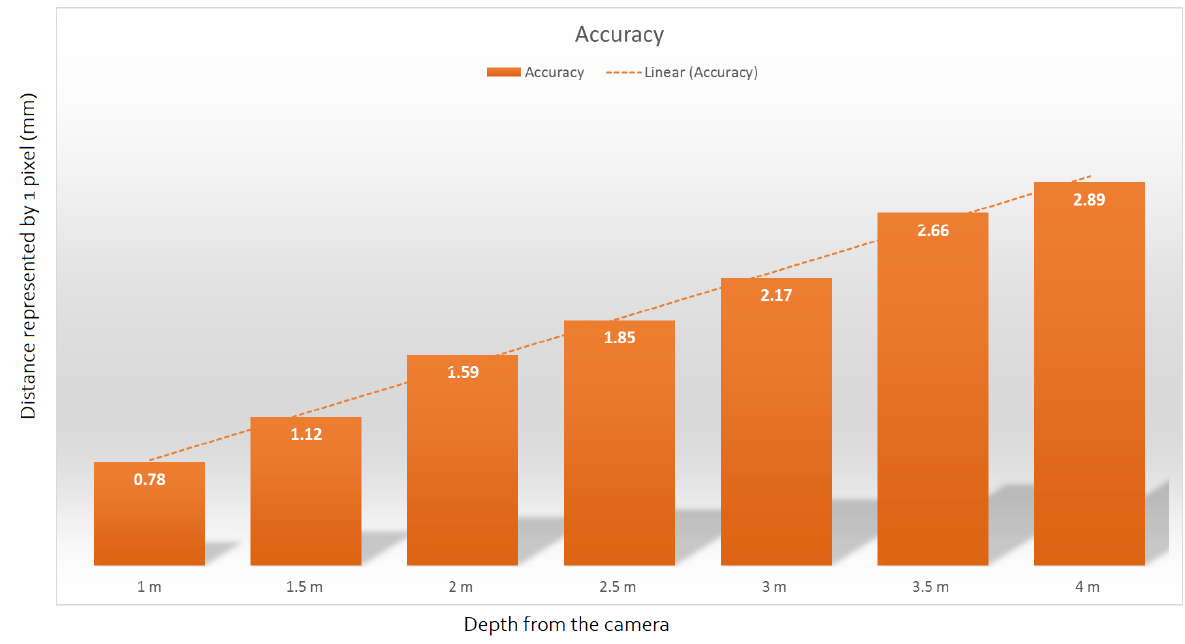
Figure 3. This figure shows how much real-world distance (mm) is represented by each pixel for different camera-to-subject distances. Note that this is assuming that the camera has HD resolution (which was the case in our data collection). The accuracy of the measurements rely on how close the subject is to the camera. The farther away the subject, the more potential error in estimating the distances in the